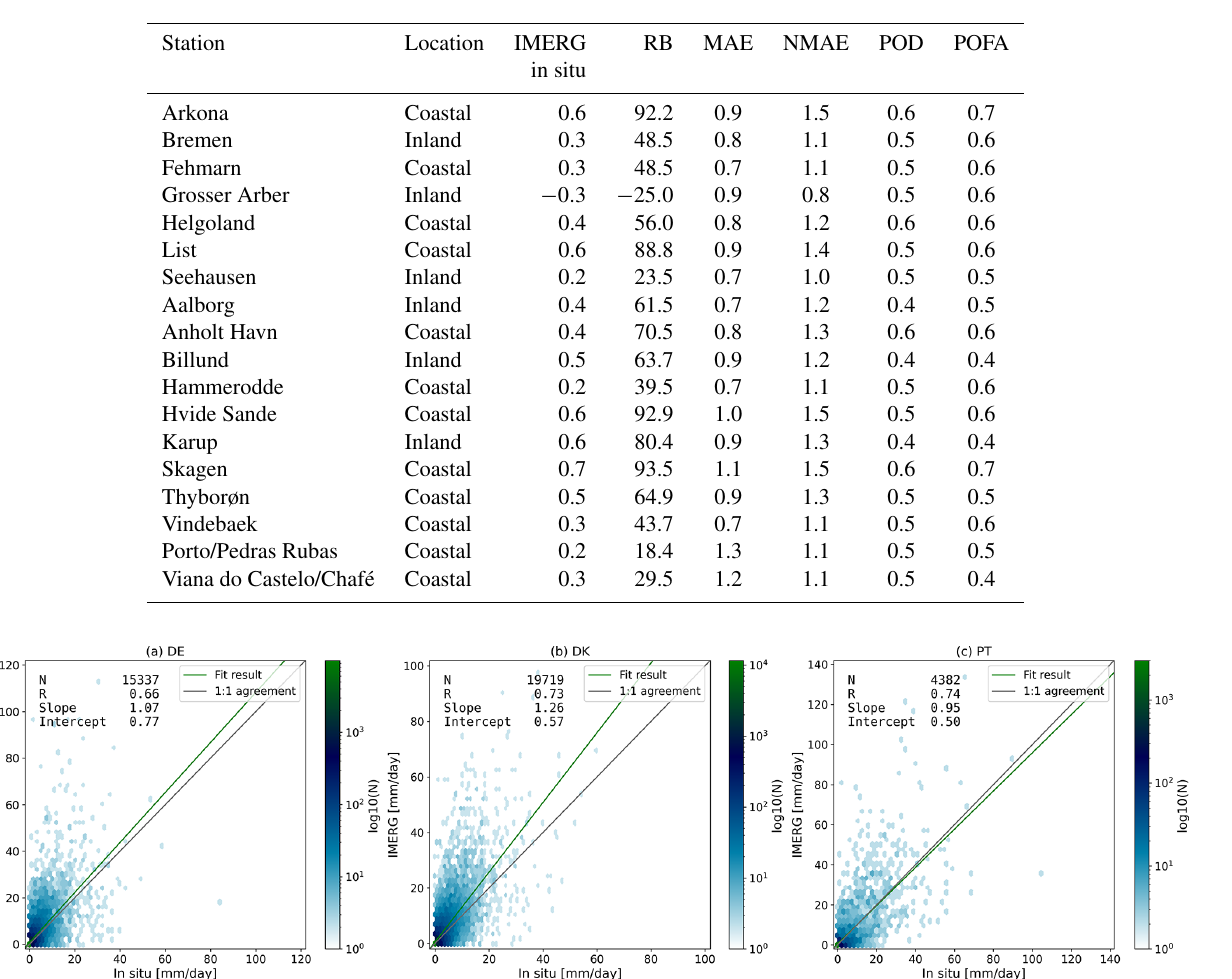
Table 2. Overall comparative statistics between the IMERG and in situ observations of the average accumulated rainfall (mm) during 30min periods in 2014–2019. RB is the relative bias, MAE is the mean absolute error, NMAE is the normalized mean absolute error, POD is the probability of detection, and POFA is the probability of false alarms.